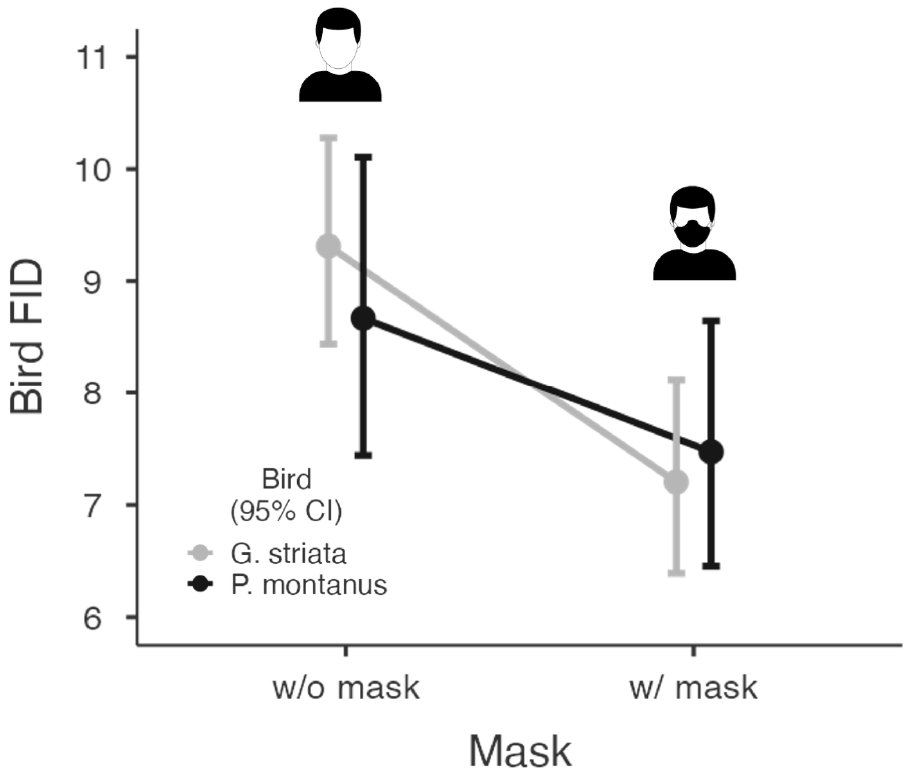
Figure 3. Visualized results of the GLM showing the effects of mask wearing on flight initiation distances of two bird species ( G. striata and P. montanus ). Whiskers indicate 95% CI.